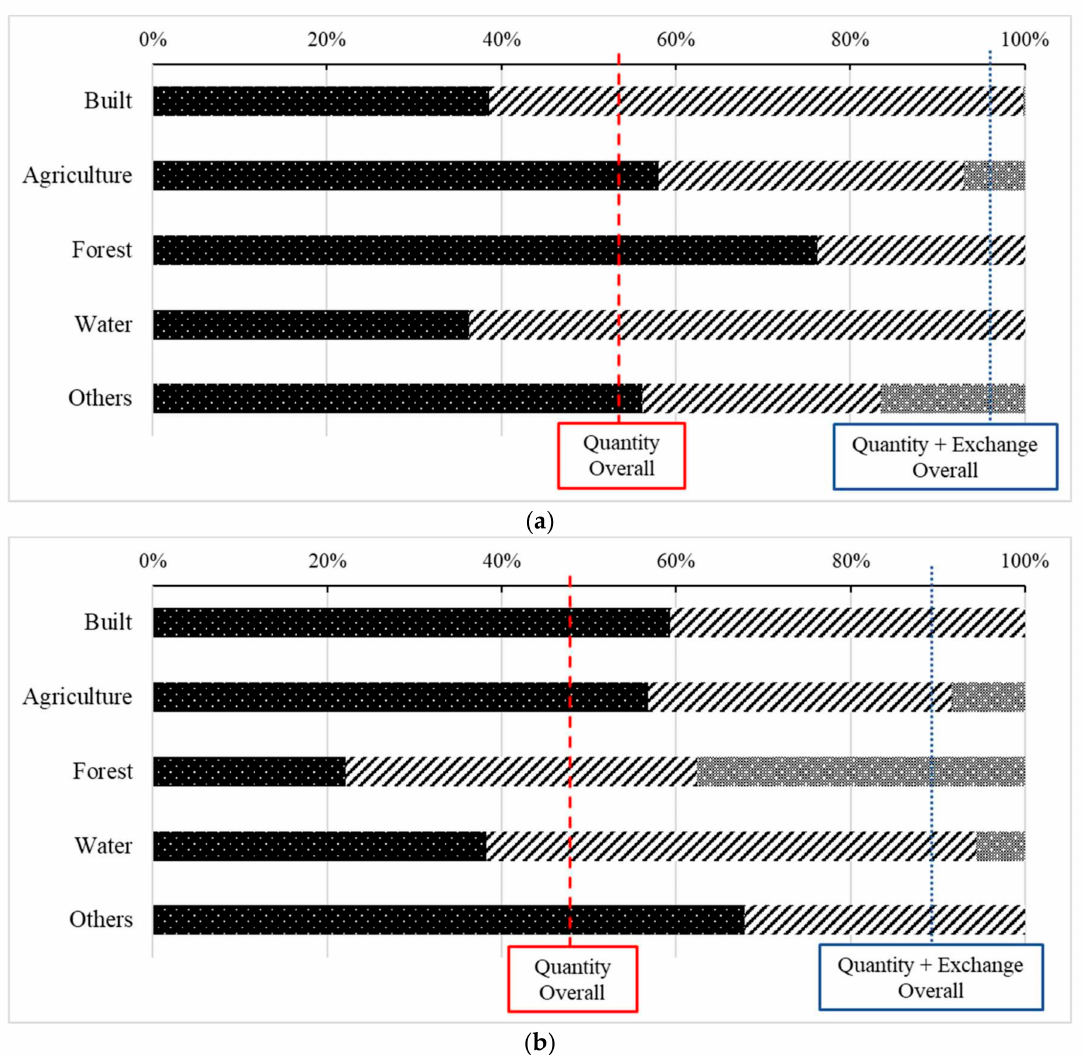
Figure 10. Category level change components in intensity during: ( a ) the colonial and ( b ) the division